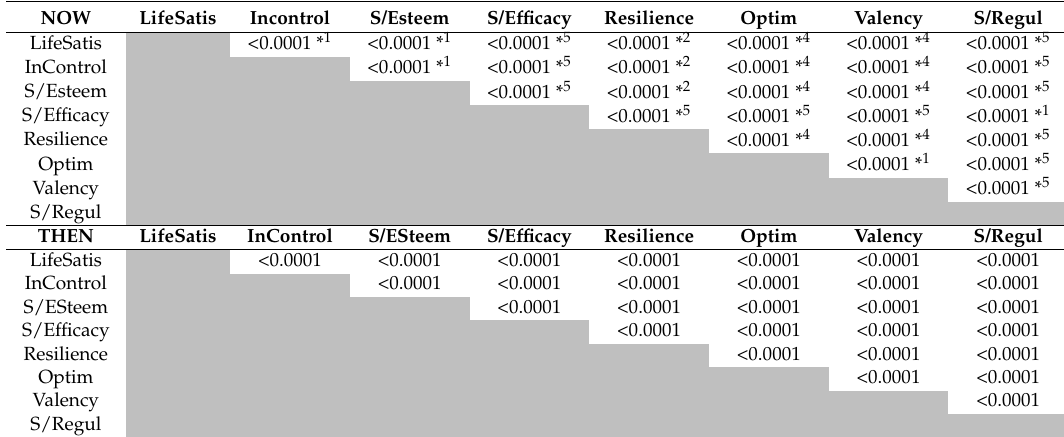
Table A12. Psychological attitudes 1.